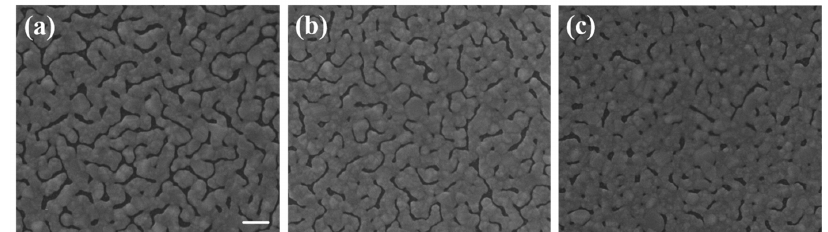
Figure 3. SEM images of sliver films with thickness of 30nm deposited on bent substrates using a fixed thermal evaporation rate at 1.2 Å/s with ( a ) glass pad area 1.2 2 cm 2 , ( b ) glass pad area 0.8 2 cm 2 , and ( c ) glass pad area 0.4 2 cm 2 underneath, respectively. They are labeled as sample D, E, and F, respectively. Scale bar: 100 nm.